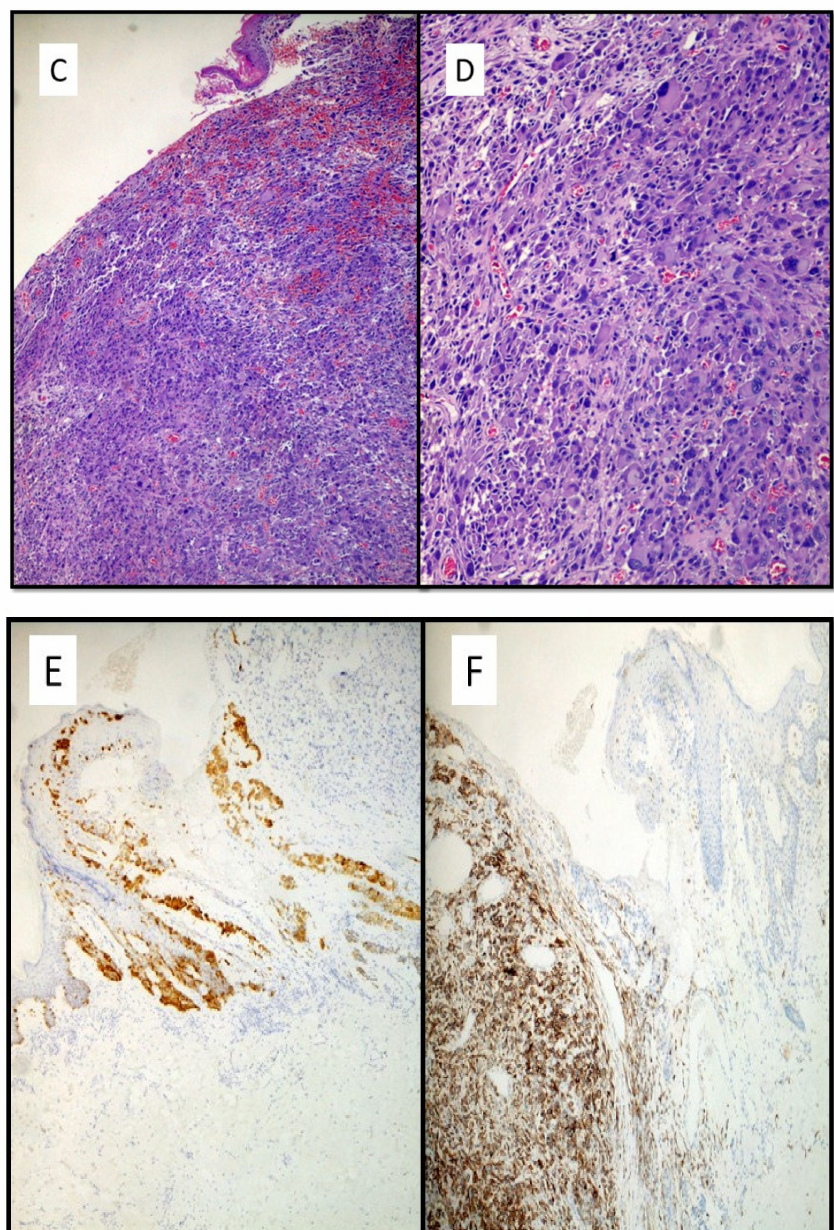
Figure 2. ( A ) The “shoulder” of the lesion was made up of atypical melanocytes, which ascended to the level of the dermoepidermal junction, morphologically suggestive of malignant melanoma. Note that the neoplastic cells had a tendency to invade the superficial/middle dermis (Hematoxylin-Eosin, Original Magnification: 10 × ). ( B ) Histological micrograph that highlights the two morphologically different components of dedifferentiated melanoma (Hematoxylin–Eosin, original magnification: 20 × ). ( C , D ) Nodule consisting of pleomorphic, atypical elements, with very numerous typical and atypical mitotic figures, eosinophilic intracytoplasmic paranuclear inclusions, nuclei with thinned chromatin and numerous central and peripheral nucleoli (Hematoxylin–Eosin, original magnification: 20 × and 40 × ). ( E ) Immunostaining for HMB-45, which is strongly represented in the melanocyte proliferation constituting the “shoulder” of the lesion morphologically represented in ( A ). Note the total negativity of HMB-45 of atypical nodular proliferation (Immunohistochemistry, original magnification: 10 × ) ( F ) Immunostaining for CD10 strongly positive in the exophytic polypoid nodular component and negative in the shoulder of the lesion (Immunohistochemistry, original magnification: 10 ×